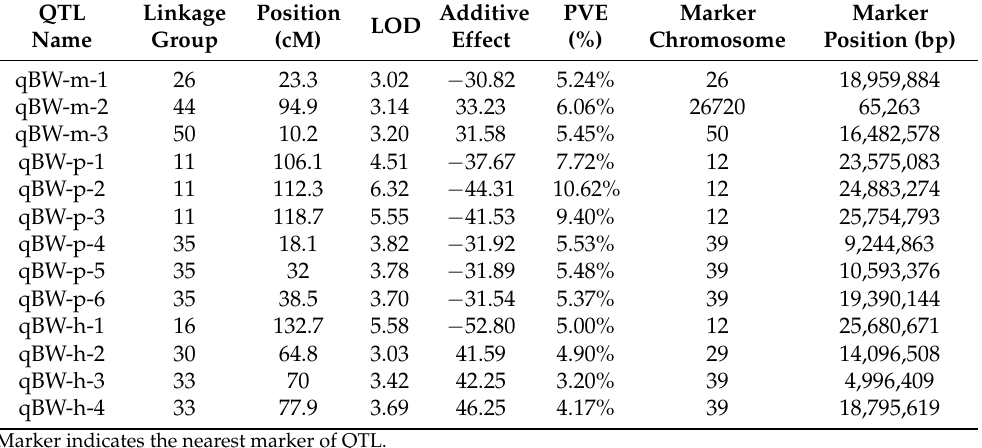
Table 5. Body weight-associated QTL identified in Yellow River carp 5–17 months after hatching.